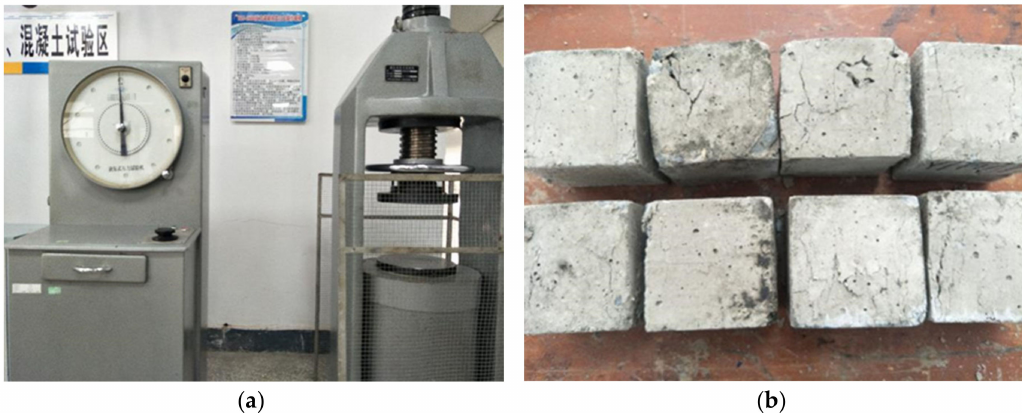
Figure 4. Compression testing machine and the damaged specimens after the test. ( a ) Compression testing machine; ( b ) damaged specimens after the compressive strength